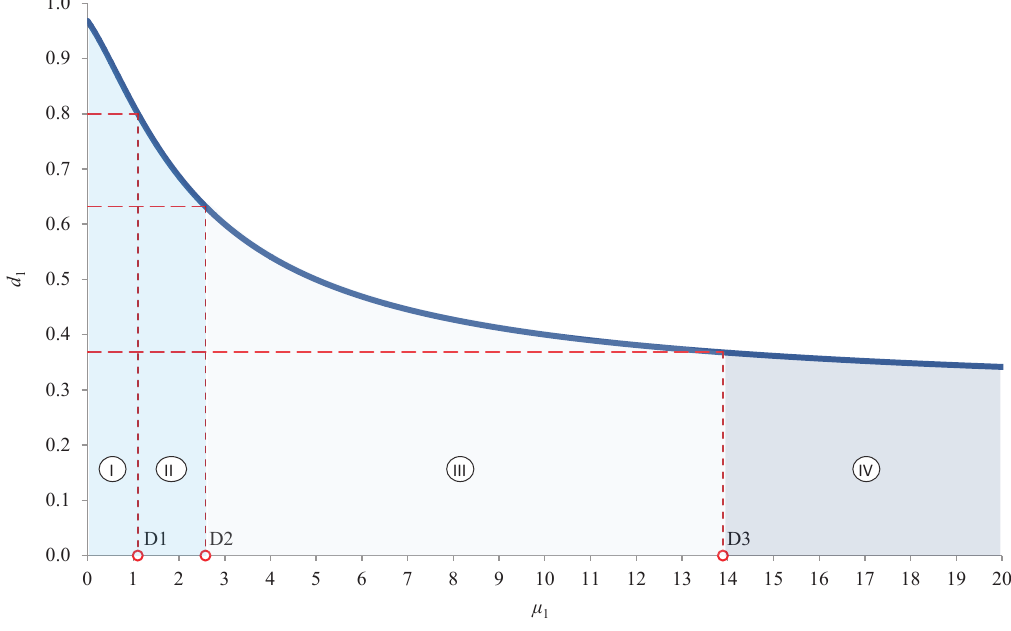
Figure 1 Graphic interpretation of Harrington’s individual desirability function given condition